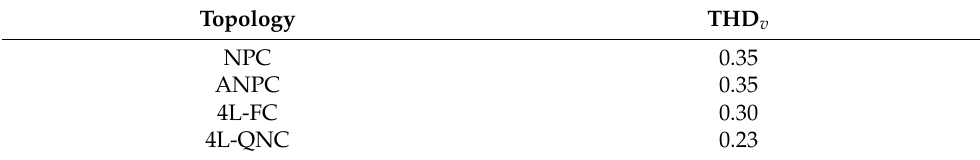
Table 4. Output voltage THD